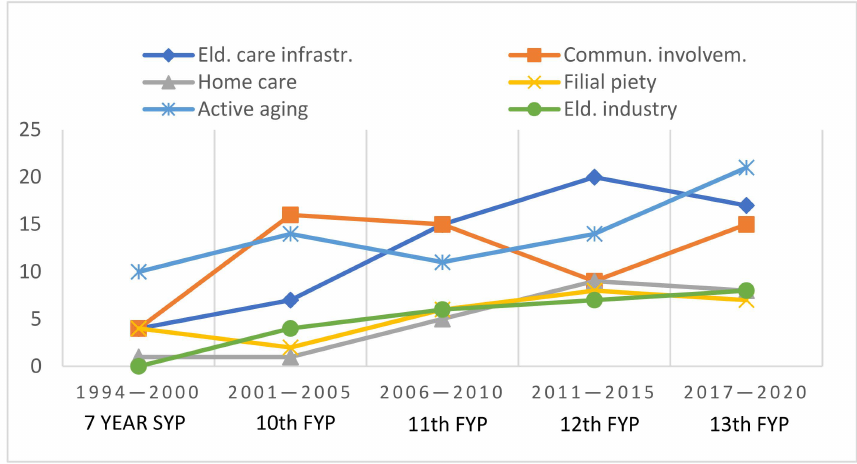
Figure 1. Frequency of attention on the six